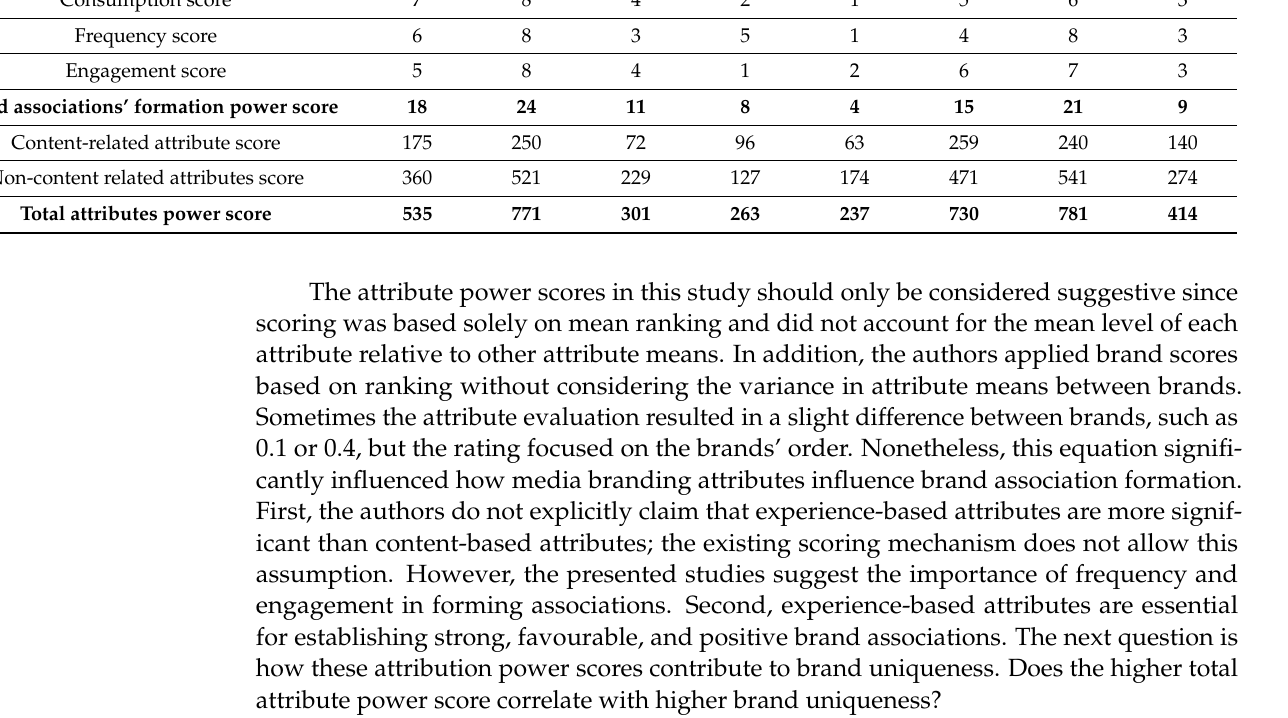
Table 10. The media attribute power scores to a 15- to 24-year-old audience in Latvia in 2022. Tvnet.lv Delfi.lv Jauns.lv La.lv Nra.lv Lsm.lv